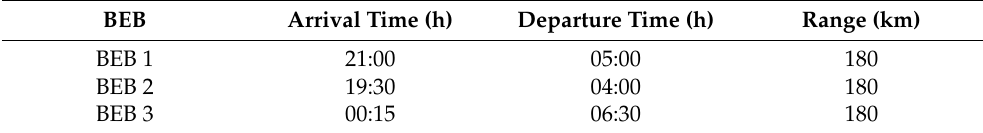
Table 2. Charging specifications of the BEBs overnight.